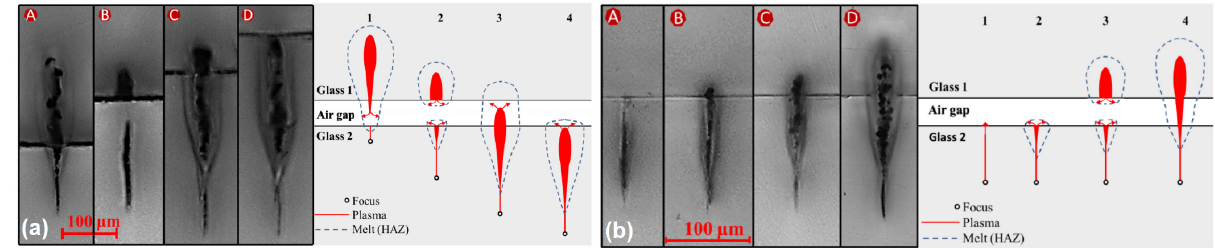
Figure 11. Cross-section of the welding process ( a ) welding dependency on focal position. The focal position is changed in this order from image A to D: − 24.1 µ m, − 40.0 µ m, − 86.5 µ m and − 107.3 µ m, Corresponding schemes of these process are shown from picture 1 to 4, ( b ) welding dependency on pulse energy, the pulse energy is increasing in this order from image A to D: 10.1, 11.23, 12.9 and 18.8 µ J, schemes of the corresponding process are shown in pictures 1 to 4